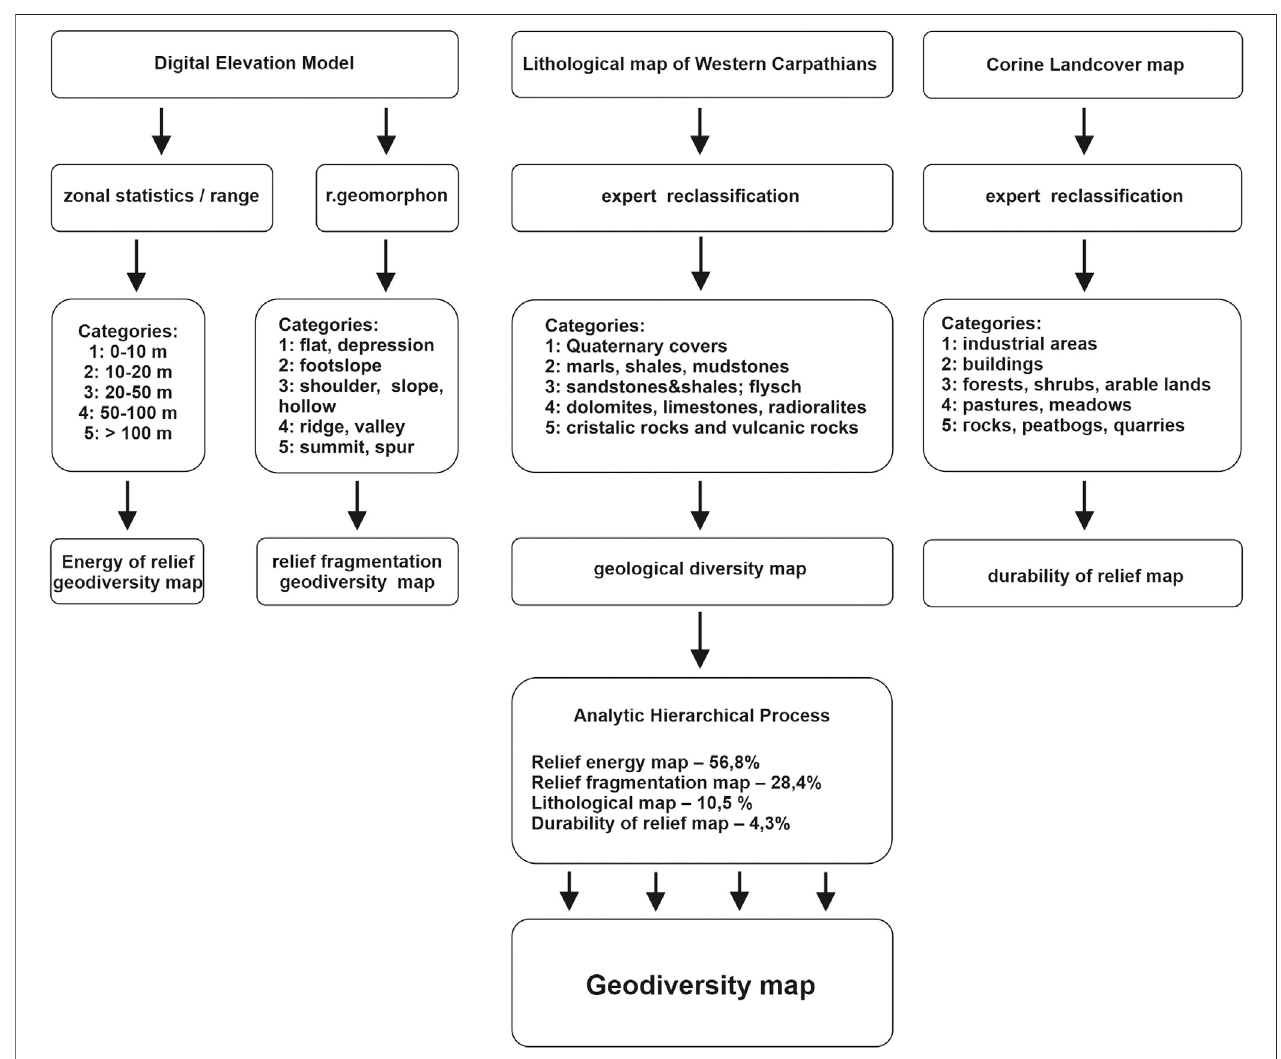
FIGURE 3 | Steps in creating a geodiversity map. Source: own study.